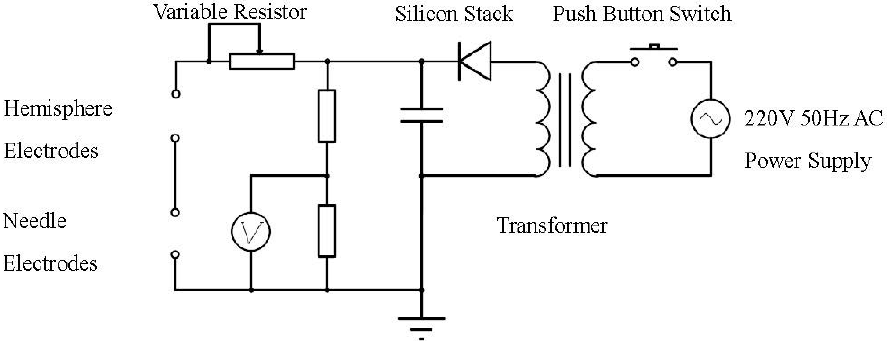
Figure 1. A circuit diagram of the spark instrument.